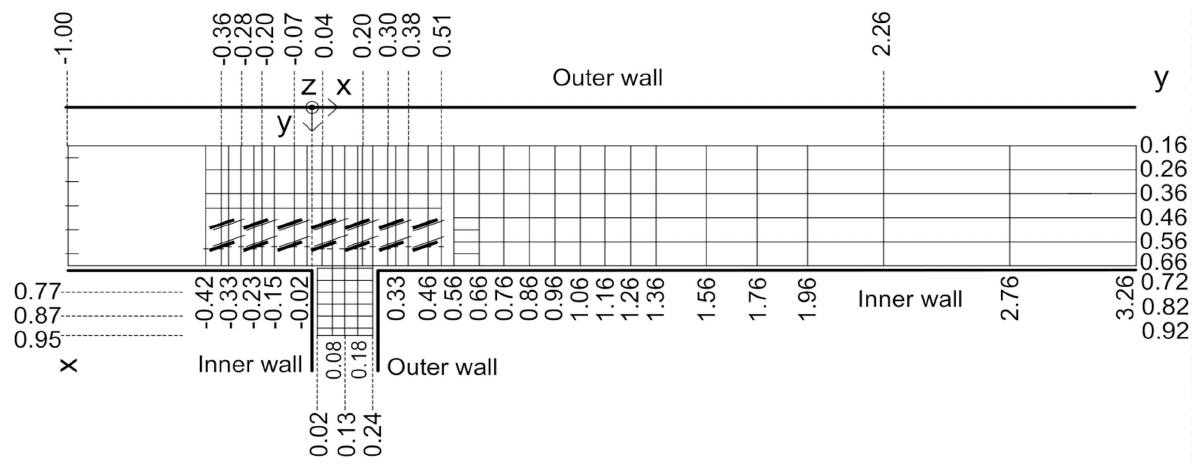
Figure 4. Plan-view of the grid of measured points in the VF experiment (lengths in